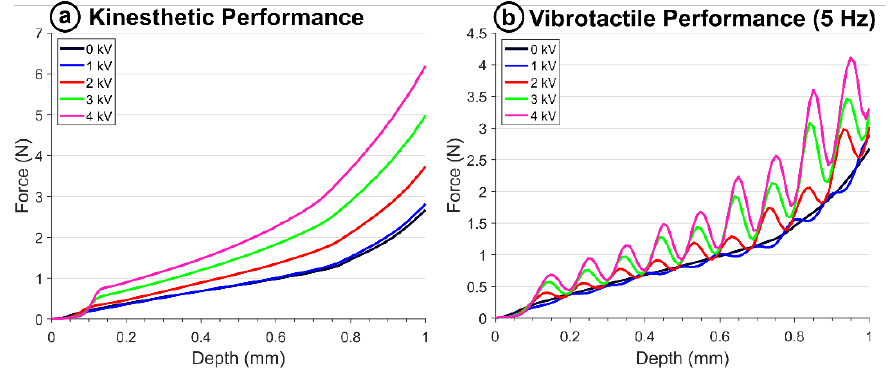
Figure 2. Experimental results: ( a ) kinesthetic testing (DC excitation) and ( b ) vibrotactile testing (AC excitation, shown: 5 Hz sine wave). Reproduced with permission [56]. Copyright 2020, IOP.